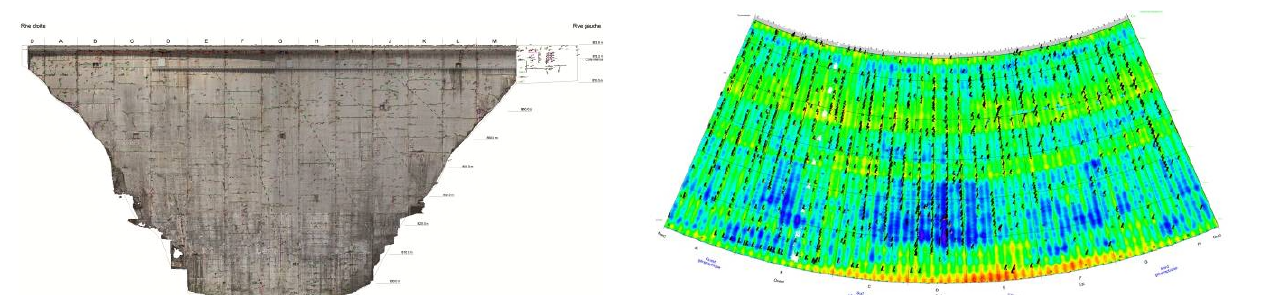
Figure 9. Orthophotography of the downstream wall with defects overlaid